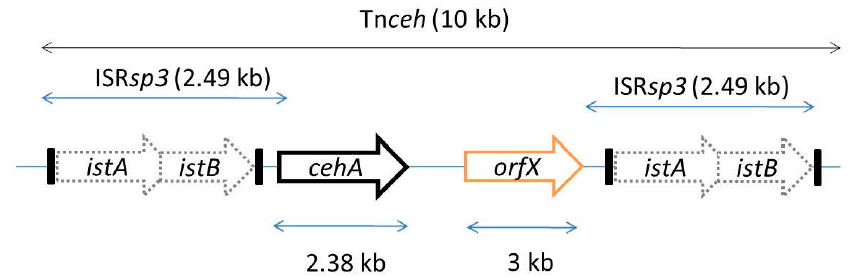
Figure 4. Organization of insertion elements observed in Carbaryl degrading Rhizobium sp. strain AC101 harboring gene cehA encoding Carbaryl hydrolase. Figure is not to scale.